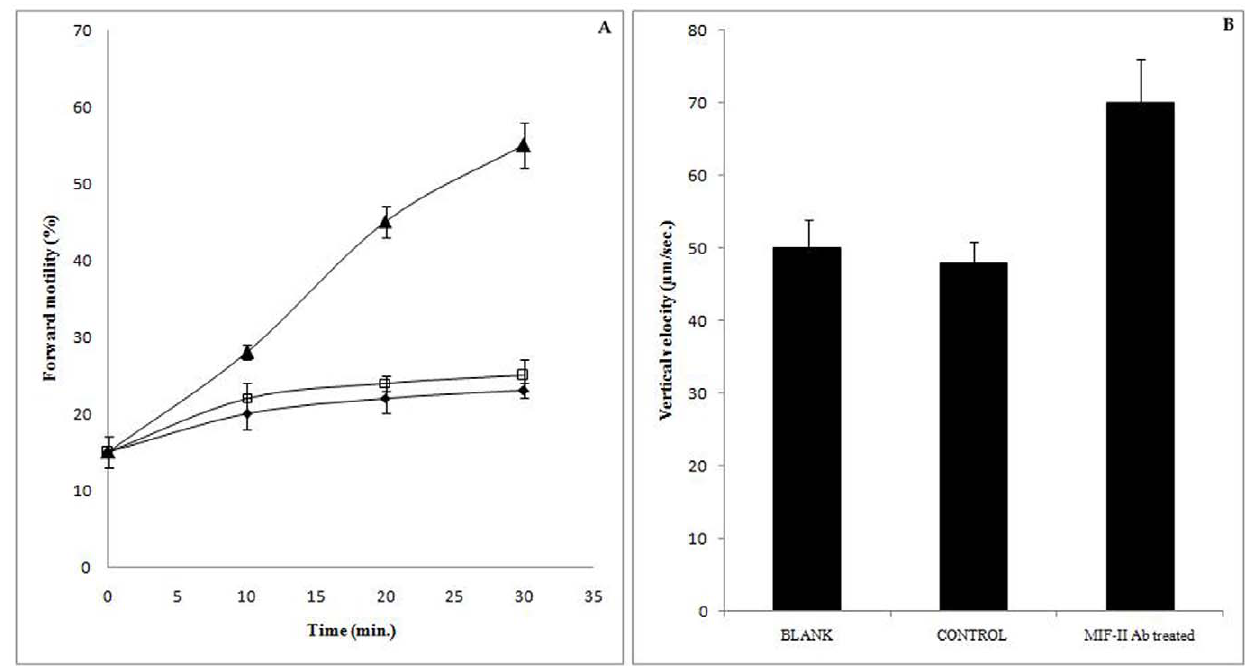
Figure 11. Effect of MIF-II antibody (1:5000) on goat cauda sperm forward motility. A) Microscopic analysis: Blank (untreated) ( ¤ ), Control with pre immune sera ( % ), MIF-II Ab ( m ). B) Analysis by SPERMA.